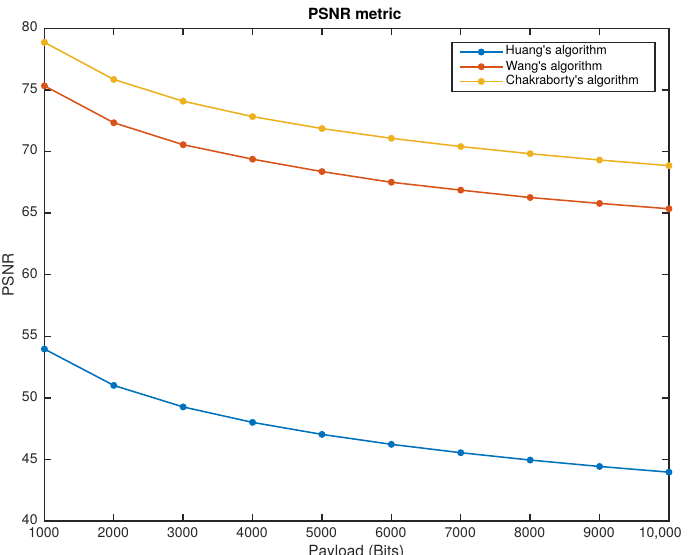
Figure 4. Fragile reversible watermarking schemes performance versus payload under PSNR metric.